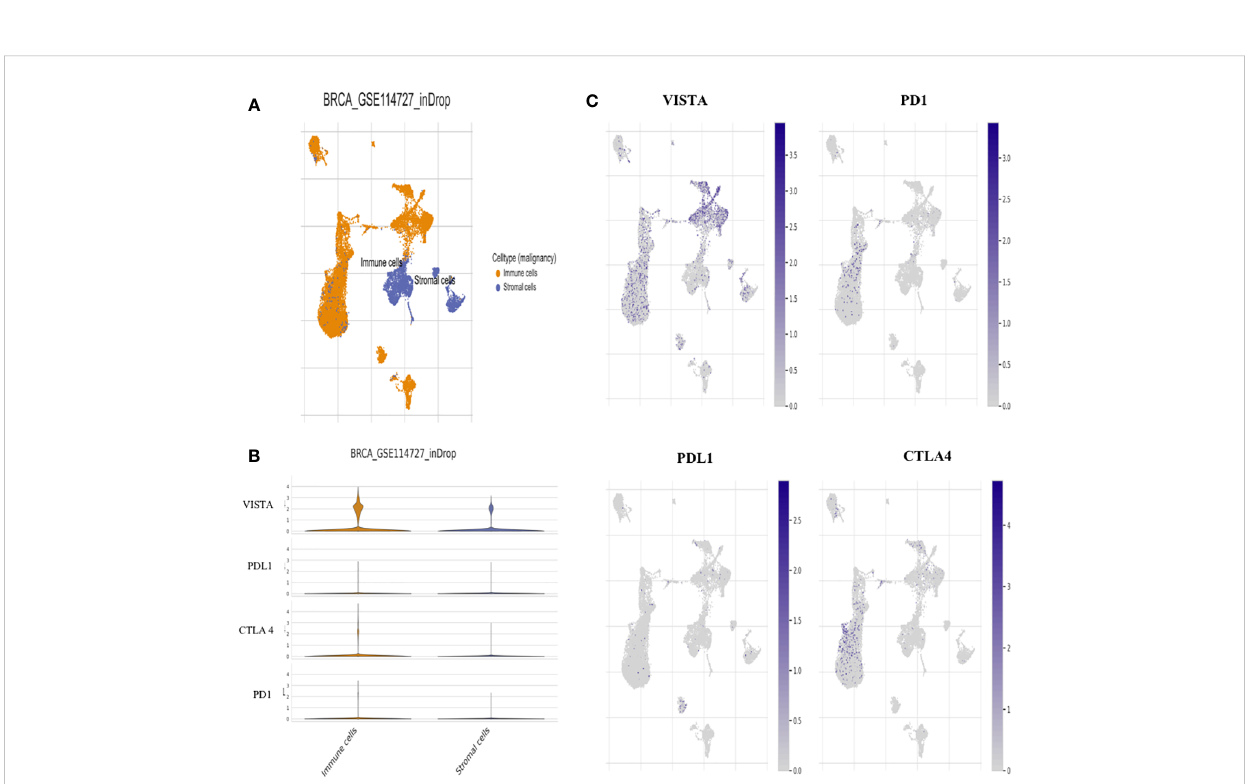
FIGURE 7 Single-cell analysis for VISTA based on Tumor Immune Single-cell Hub (TISCH) database. (A) Uniform manifold approximation and projection (UMAP) plots showing the Breast cancer cell landscape based on GSE114727_inDrop. (B) Violin plots for the expression of VISTA, PDL1, CTLA4, and PD1 on Immune and stromal cells based on GSE114727_inDrop. (C) UMAP plots illustrating the expression of VISTA, PD1, PDL1, and CTLA4 clusters based on GSE114727_inDrop.